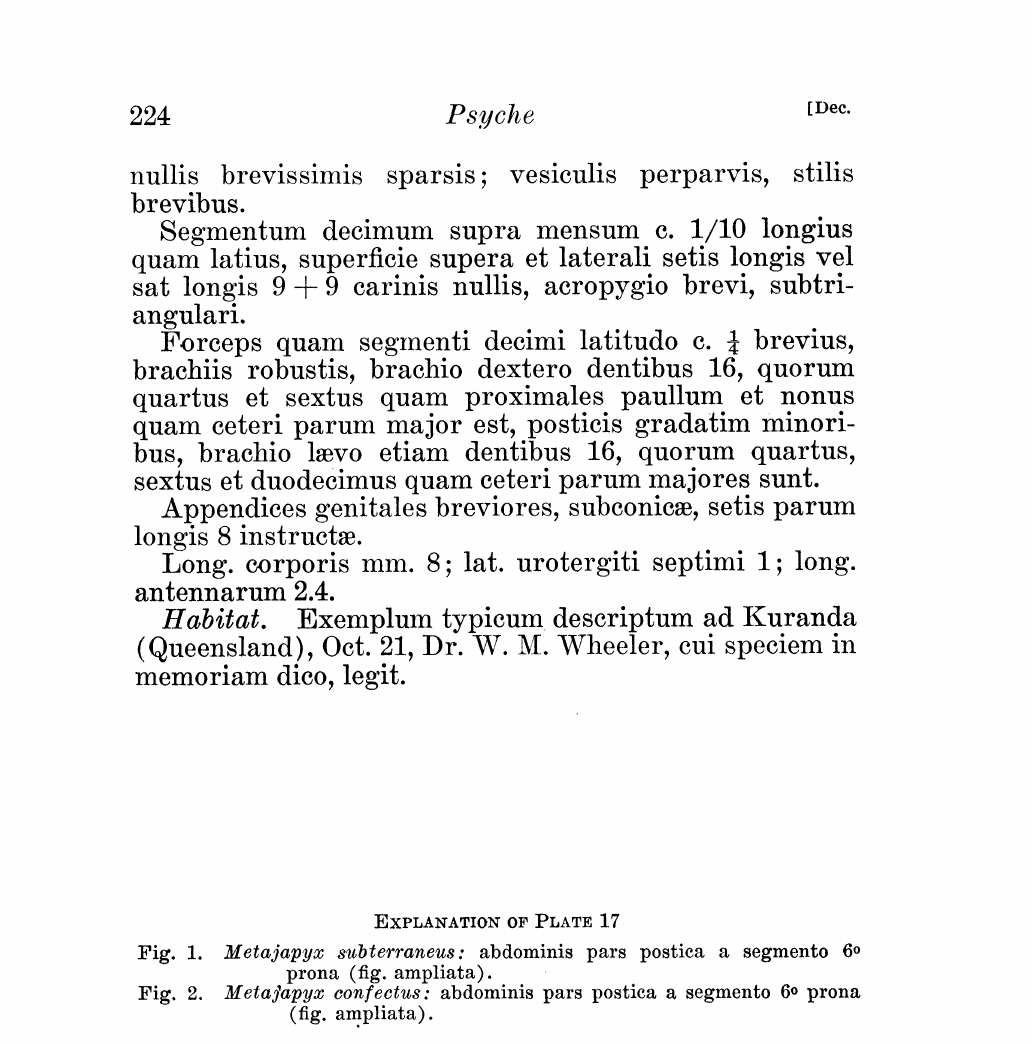
Fig. 1. Metajapyx subterraneus: abdominis pars postica a segmento 60 prona (fig. ampliata). Fig. 2. Meta]apyx confectus: abdominis pars postica a segmento 60 prona (fig.